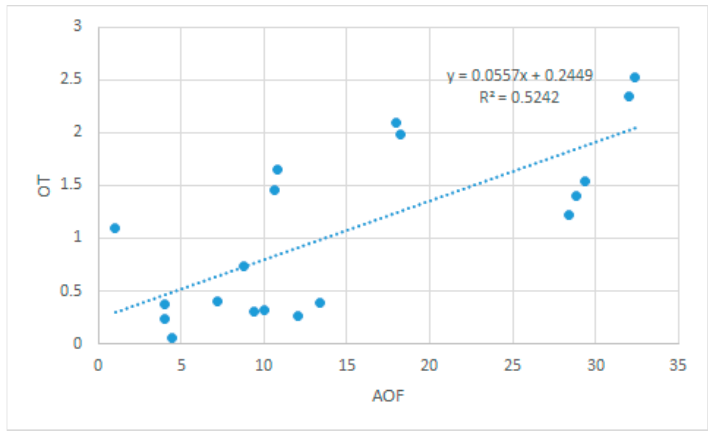
Figure 6. The graph that illustrates the direct correlation between OT and AOF in NHP.